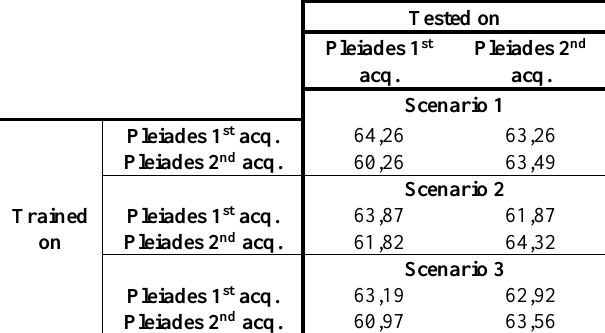
This contribution has been peer-reviewed. The double-blind peer-review was conducted on the basis of the full paper. https://doi.org/10.5194/isprs-annals-V-2-2020-525-2020 | © Authors 2020. CC BY 4.0